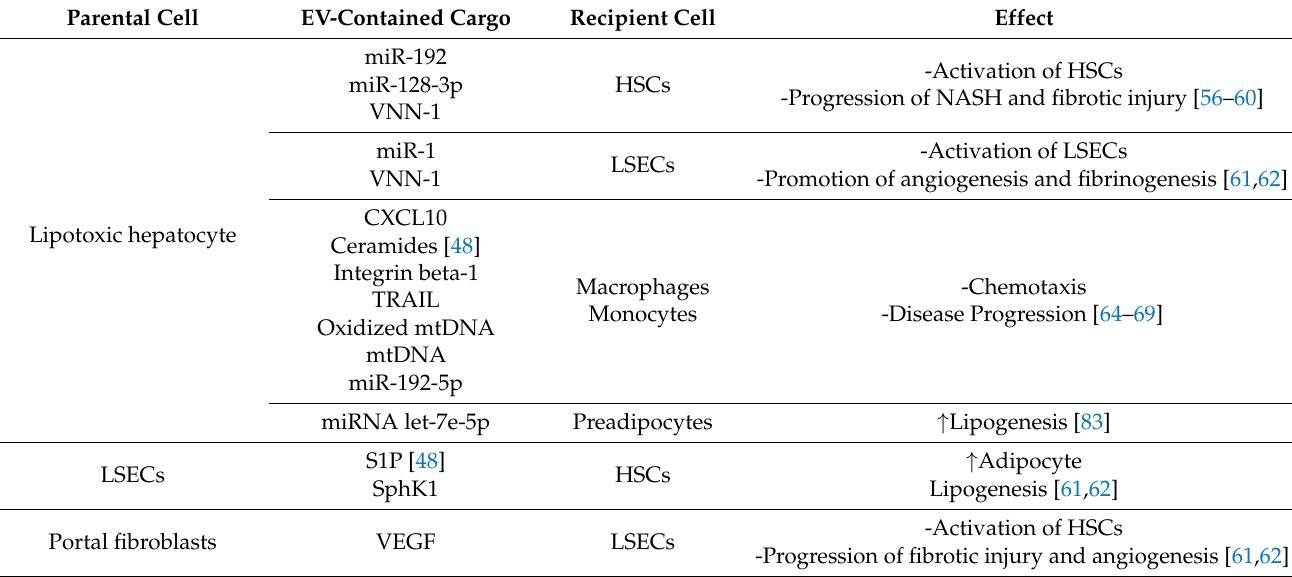
Table 1. A summary of the effects of EVs on NASH